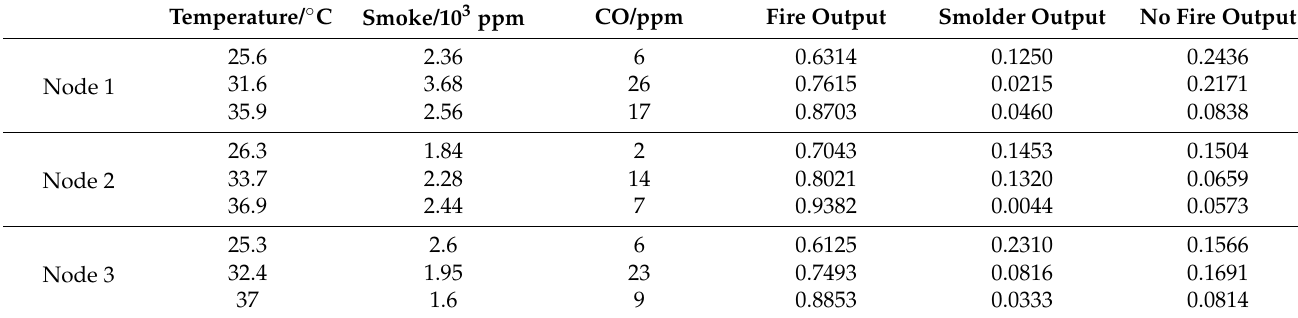
Table 10. The PSO-LSSVM algorithm fusion results.